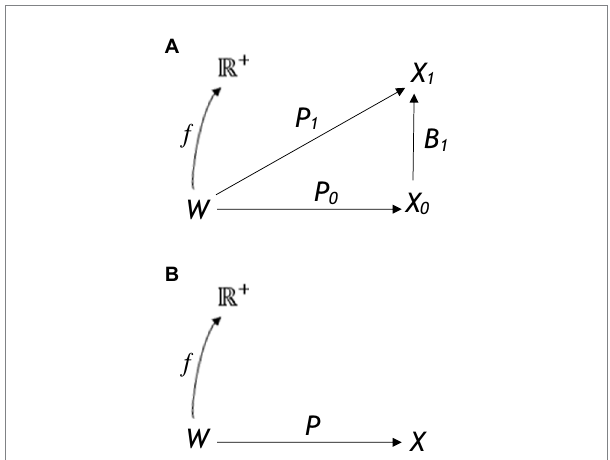
FIGURE 1 (A) The framework of computational evolutionary perception W is the observer-independent world, X 0 and X 1 are two perceptual (or representational) spaces, and P 0 and P 1 their respective perceptual channels f is a fitness map. In (B) , a framework to define the two resource strategies. A fixed perceptual map is assumed : → P